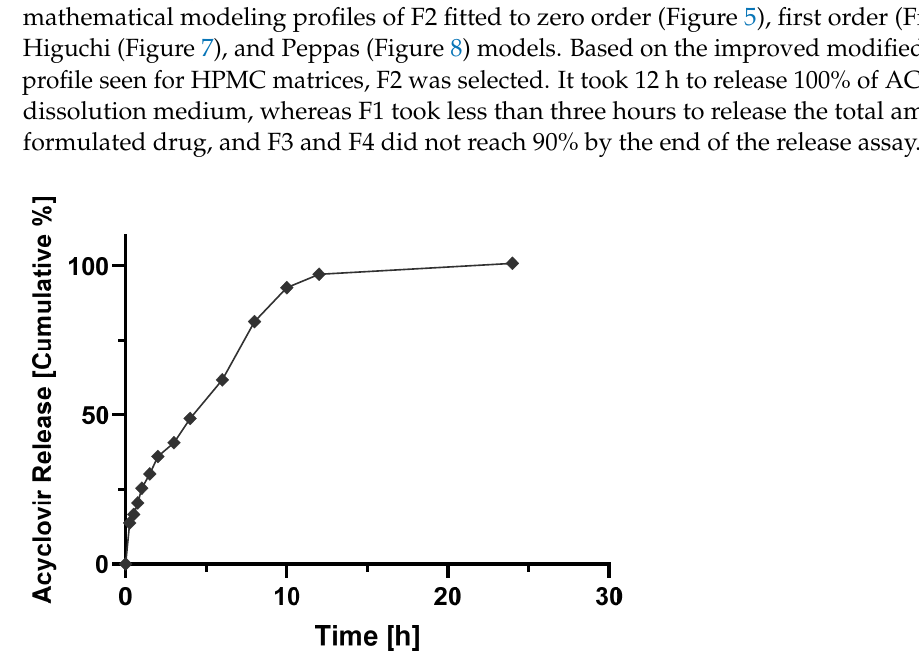
Figure 5. Cumulative percentage of acyclovir from F2 released formulation as a function of time (h) fitted to zero order kinetics ( y = 4.452 x + 24.332; R 2 = 0.7703).